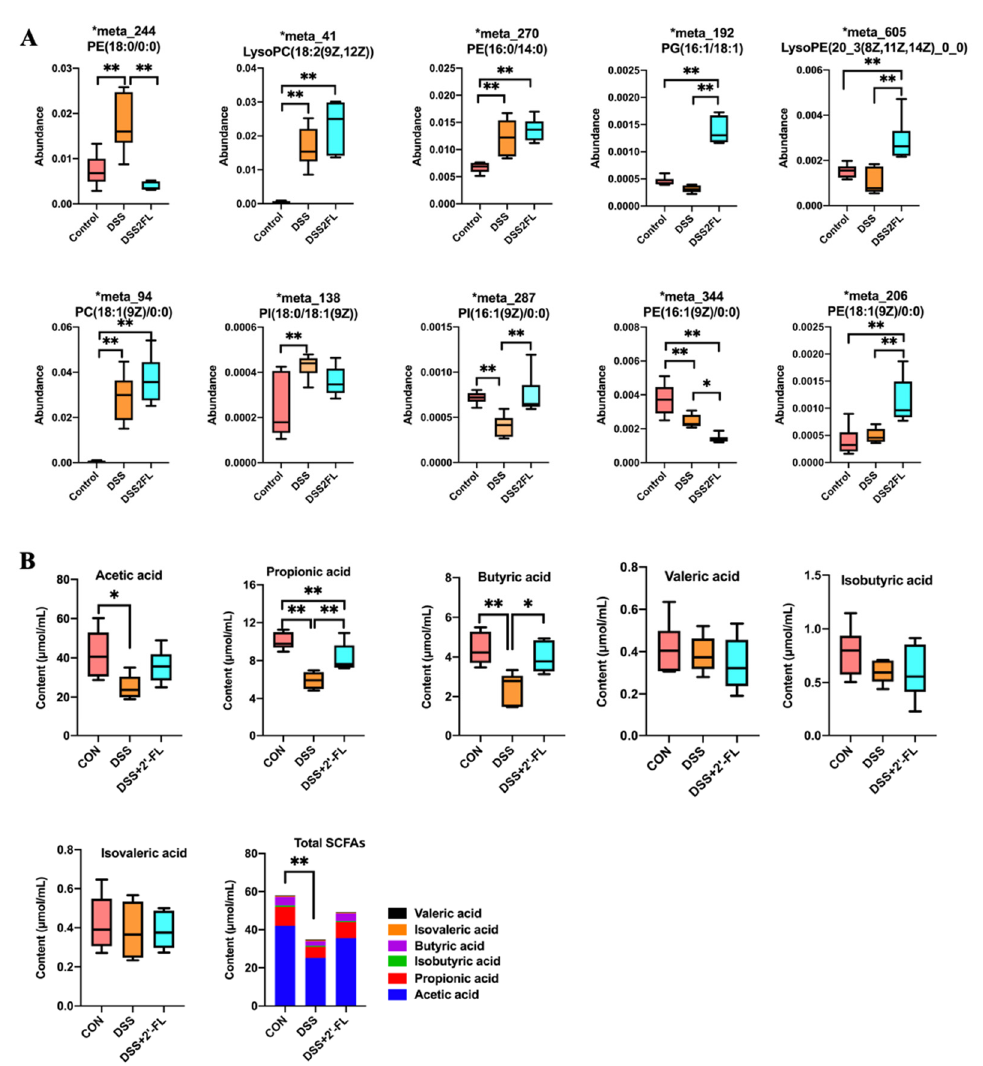
Figure 5. The profile of lipid metabolism and SCFAs was significantly influenced among the three groups. ( A ) The levels of metabolites related to lipid metabolism; ( B ) The contents of SCFAs. Signif- icance was determined using one-way ANOVA ( n = 6 for each group). *, p < 0.05. **, p < 0.01. PE, phosphatidyl ethanolamine; PI, phosphatidyl inositol; PC, phosphatidyl choline; PG, phosphatidyl glycerol; LysoPC, lysophosphatidyl choline; LysoPE, lysophosphatidyl